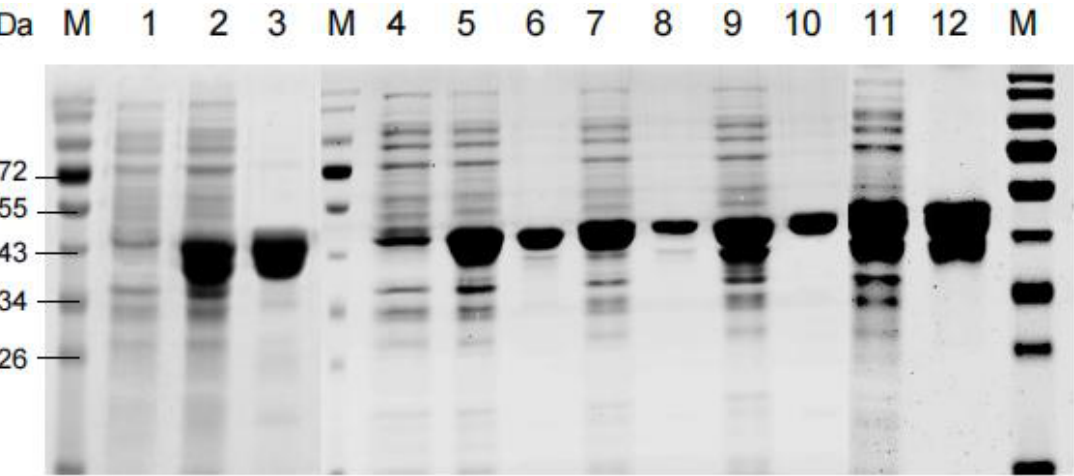
Figure 6. SDS-PAGE of purified recombinant proteins of XynA and its variants. Lane M: molecular weight markers; lane 1 and 4: culture supernatant of pET-28a(+) in E. coil BL21; lane 2: culture supernatant of XynA-Tr; lane 3: purified XynA-Tr; lane 5: culture supernatant of XynA-Tr-C15; lane 6: purified XynA-Tr-C15; lane 7: culture supernatant of XynA-Tr-C30; lane 8: purified XynA- Tr-C30; lane 9: culture supernatant of XynA-Tr-C45; lane 10: purified XynA-Tr-C45; lane 11: culture supernatant of XynA; lane 12: purified XynA.